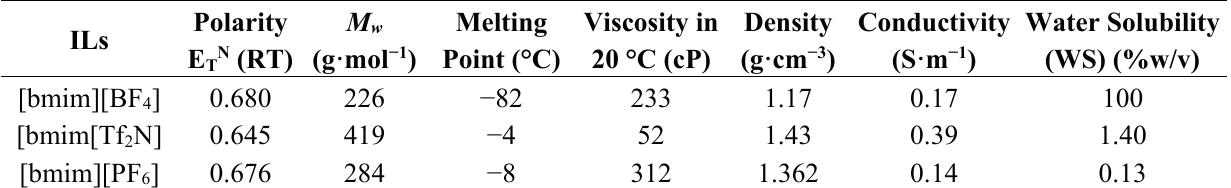
Table 4. Physicochemical properties of ILs commonly used in